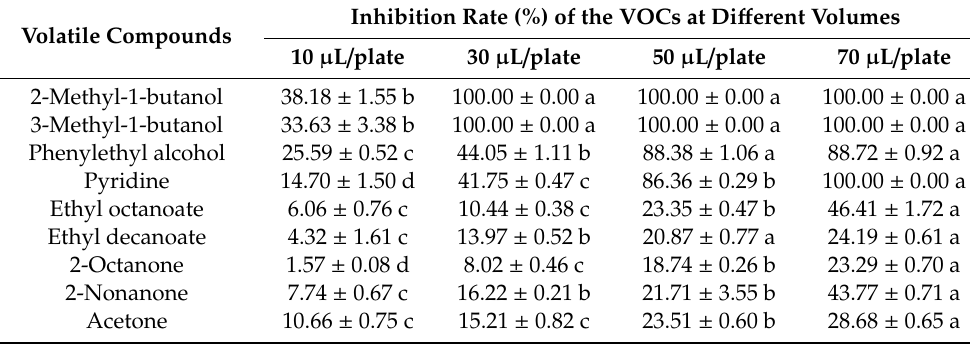
Table 3. Inhibition e ff ects of the VOCs on C. fimbriata mycelial